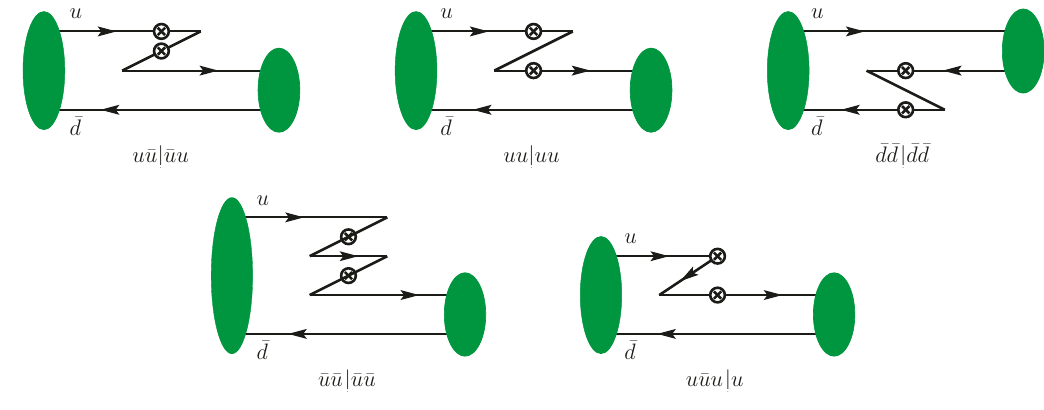
Figure 13 . As figure 12, but for graph C 2